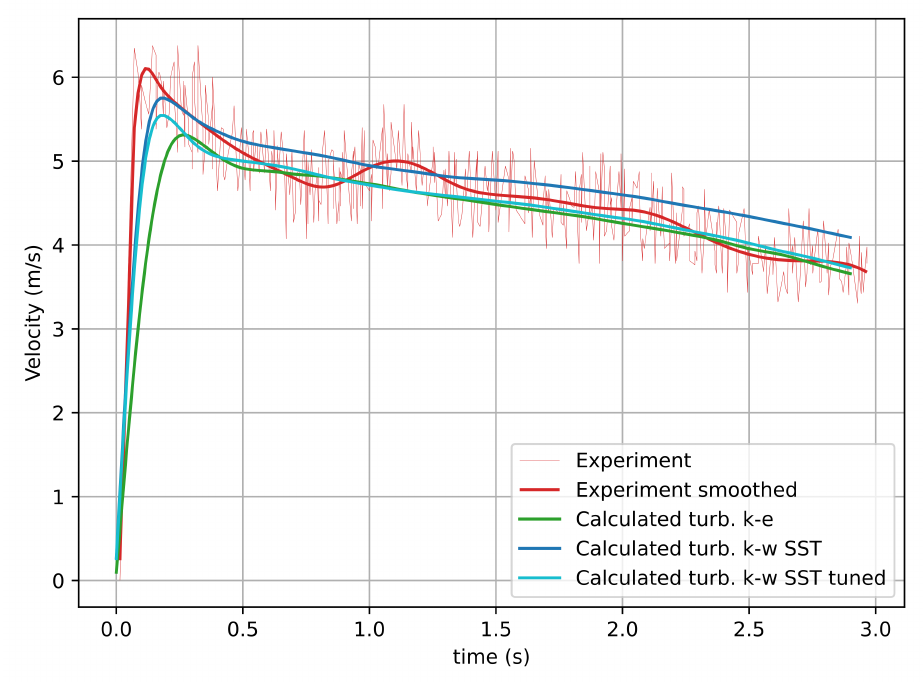
Figure 9. Depth-averaged velocity measured at a distance of 11.1 meters from the beginning of the chute without dams. The water boundary is defined by a water volume fraction of 90%. The experimental data taken from [38] (Experiment) colored in red, calculated data obtained by the authors using the k - ε turbulence model (Calculated k-e ) colored in green, calculated data obtained by the authors using the k - ω SST turbulence model (Calculated k-w SST ) colored in blue and calculated data obtained by the authors using the k - ω SST turbulence model (Calculated k-w SST tuned) with tuned coefficients colored in